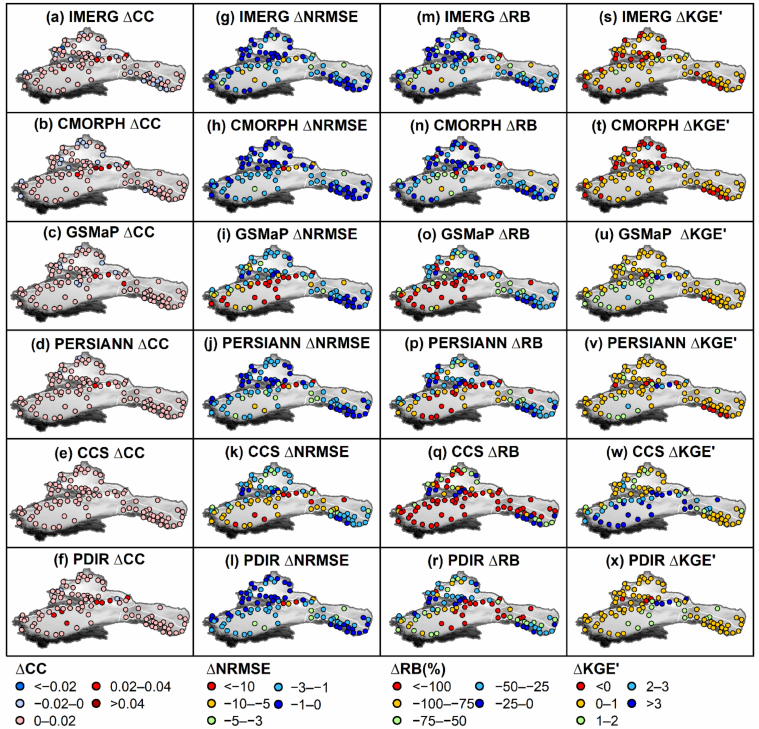
Figure 3. Spatial patterns of the changes of continuous metrics for six SPPs. The ( a – f ), ( g – l ), ( m – r ), and ( s – x ) display the ∆ CC, ∆ NRMSE, ∆ RB, and ∆ KGE (cid:48) for six SPPs, respectively.